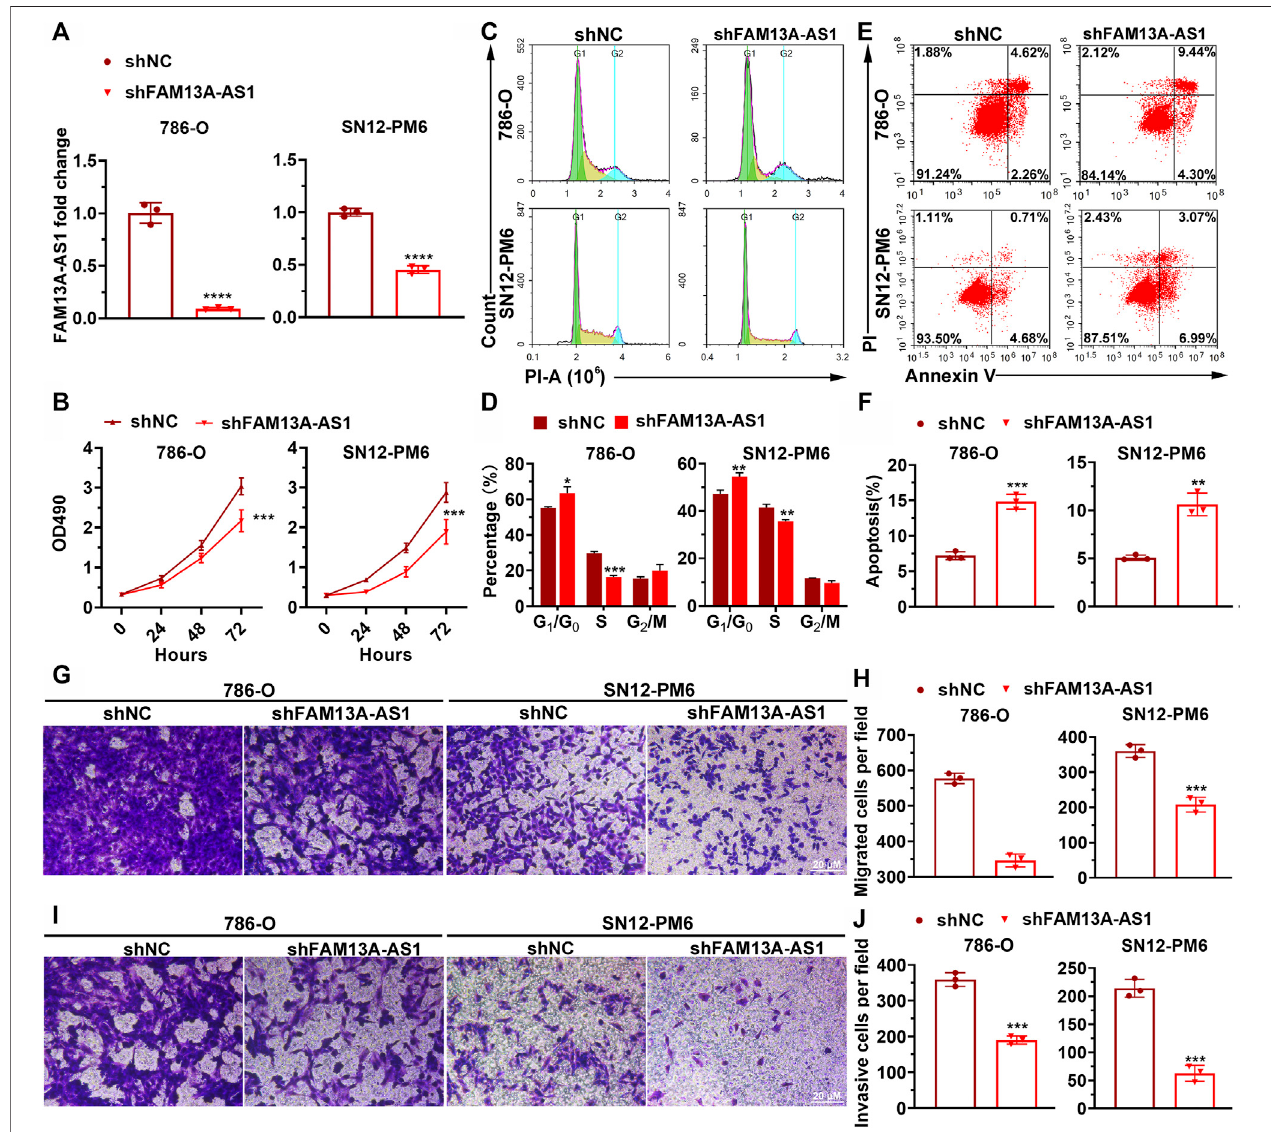
FIGURE2| FAM13A-AS1promotes RCCcellproliferation,migration, andinvasion. (A) Barplotshowingtheknockdown ef fi cienciesofshRNAtargetingFAM13A- AS1.ExpressionlevelsweremeasuredbyRT-qPCRandcalibratedusingtheexpressionlevelof18SrRNA.Foldchangesinexpressionwerethencomputedagainstthe scrambledcontrol. (B) MTTassayofRCCcellstransfectedwithshFAM13A-AS1orscrambledcontrol. (C,D) Representativehistograms (C) andquanti fi cation (D) ofcell cycledistribution ofRCCcellstransfectedwith shFAM13A-AS1 or scrambled control. X and Y axes in (C) denote DNA contentand cell number, respectively. (E,F) Dot plot (E) and bar chart (F) of Annexin V/PI two-parameter fl ow cytometry analysis of RCC cells transfected with shFAM13A-AS1 or scrambled control. Bar plot (F) shows the percentages of cells that underwent apoptosis. (G,H) Representative images (G) and quanti fi cation (H) of the Transwell migration assay in RCC cells transfected with shFAM13A-AS1 or scrambled control. (I,J) Representative images (I) and quanti fi cation (J) of the matrigel invasion assay in RCC cells transfected with shFAM13A-AS1 or scrambled control. Data represent the mean ± SD. **: p < 0.01; ***: p < 0.001; ****: p < 0.0001.